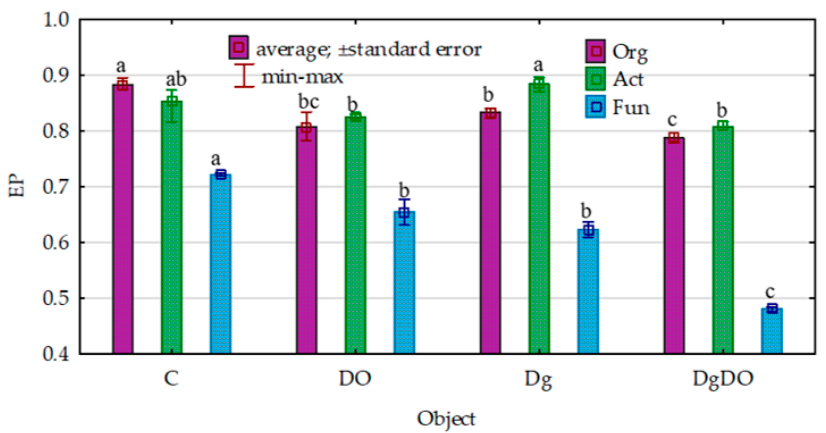
Figure 2. Effect of diesel oil (DO) and Dactylis glomerata (Dg) on the ecophysiological diversity index (EP) of the microorganisms. Homogeneous groups denoted with letters (a–c) were calculated separately for each of the microorganisms. C—non-polluted and non-sown soil, Dg—non-polluted soil sown with Dactylis glomerata , DO—non-sown soil polluted with diesel oil, DgDO—soil polluted with diesel oil and sown with Dactylis glomerata.